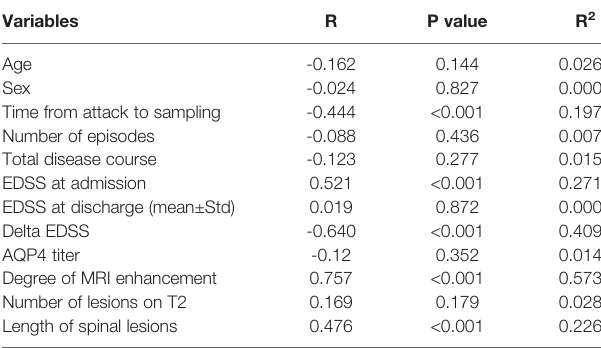
TABLE 2 | Correlation of serum levels of RGMa with clinical parameters in NMOSD. Variables R P